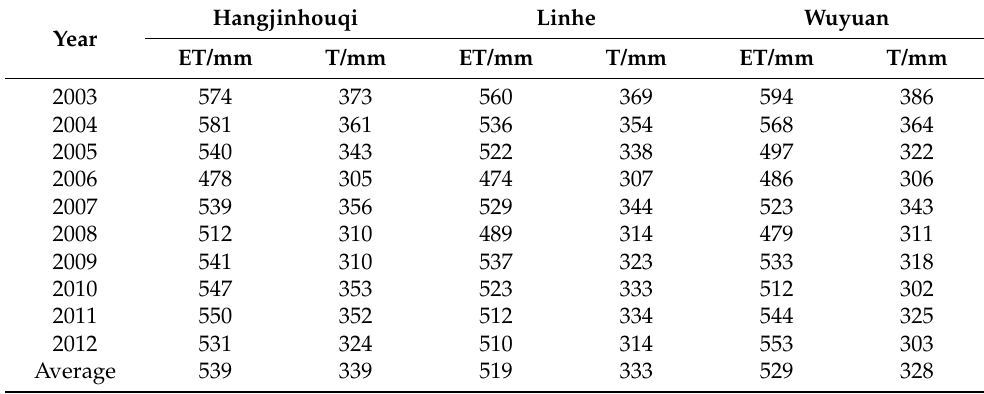
Table A3. ET and T of maize during the growing seasons from 2003 to